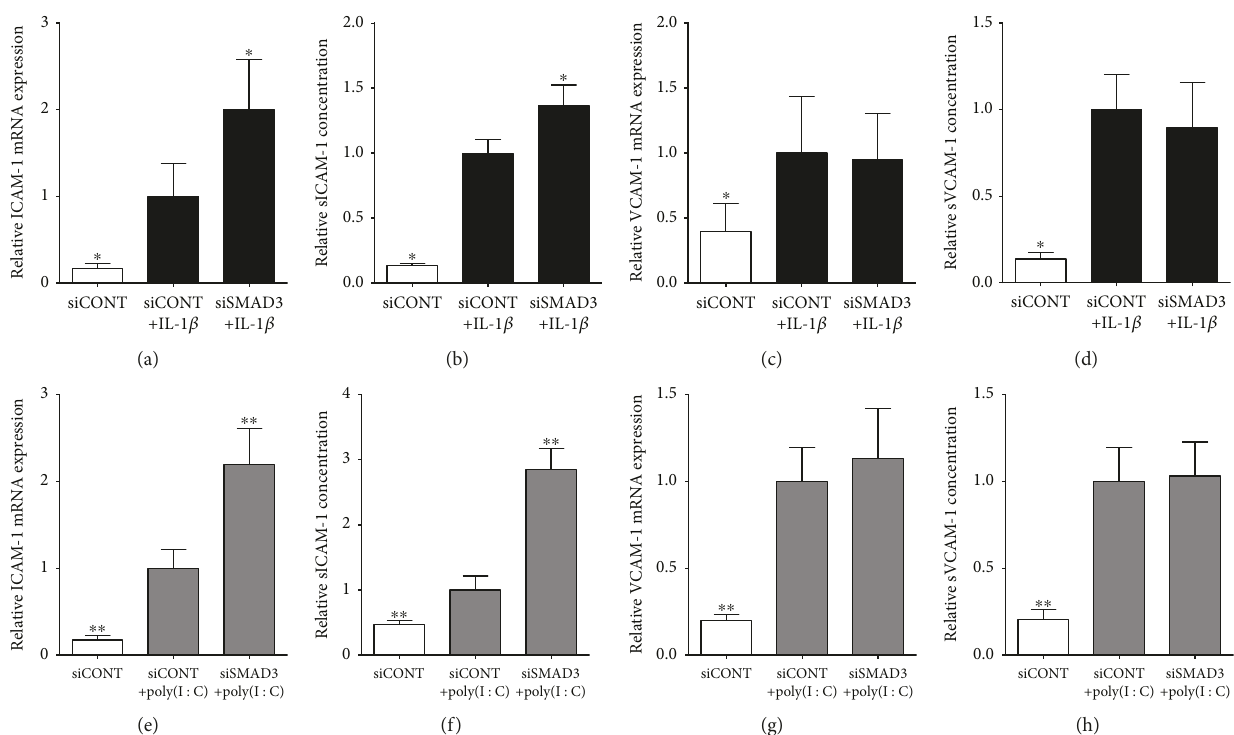
Figure 5: E ff ect of siSMAD3 on the expression and secretion of adhesion molecules. Human primary myometrial cells, obtained from women at term in the absence of labour, were transfected with or without 50 nM siSMAD3 or 50 nM siCONT for 48h and then treated with (a – d) 1ng/ml IL-1 β or (e – h) 5 μ g/ml poly(I:C) for an additional 24h ( n = 5 patients). (a, c, e, g) Expression of ICAM-1 and VCAM-1 mRNA was analysed by qRT-PCR. (b, d, f, h) sICAM-1 and sVCAM-1 concentrations in the incubation media were assayed by ELISA. The fold change was calculated relative to IL-1 β - or poly(I:C)-stimulated siCONT-transfected cells and data displayed as mean ± SEM. ∗ P ≤ 0 05 vs. IL-1 β -stimulated siCONT-transfected cells (one-way ANOVA). ∗∗ P ≤ 0 05 vs. poly(I:C)-stimulated siCONT-transfected cells (one- way